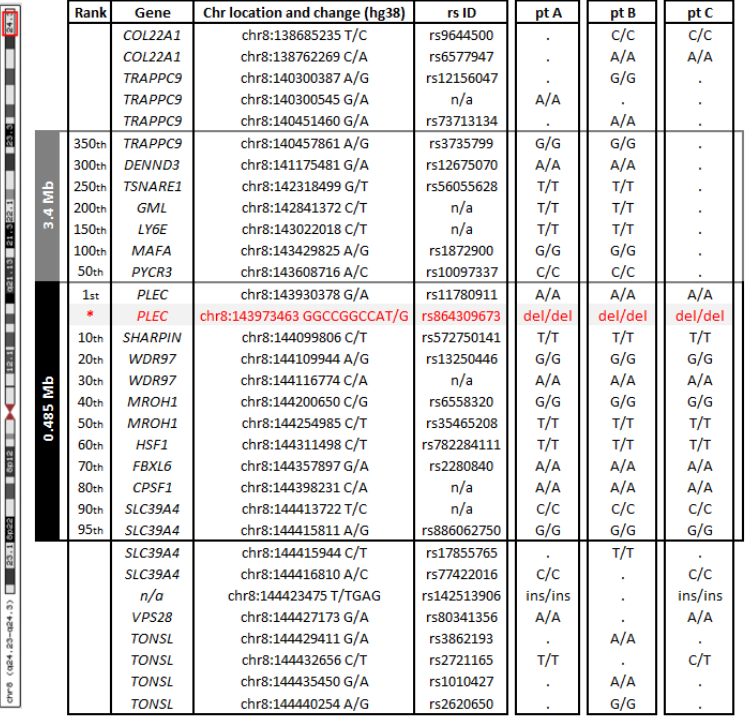
Figure 4. Common haplotype based on WES data. Patients A, B, and C shared a 0.485 Mb haplotype (defined by 95 variants and encompassing 17 genes; shown in black) from chr8:143930378 to chr8:144415811. Patients A and B shared a larger haplotype (3.4 Mb, in grey), defined by ~350 variants from chr8:140457861 to chr8:143608716 and encompassing 45 genes. Selected variants and their genotypes are indicated both within and outside the haplotype. A dot indicates that the variant was not present in that patient. The PLEC mutation identified in the four Turkish patients is shown in